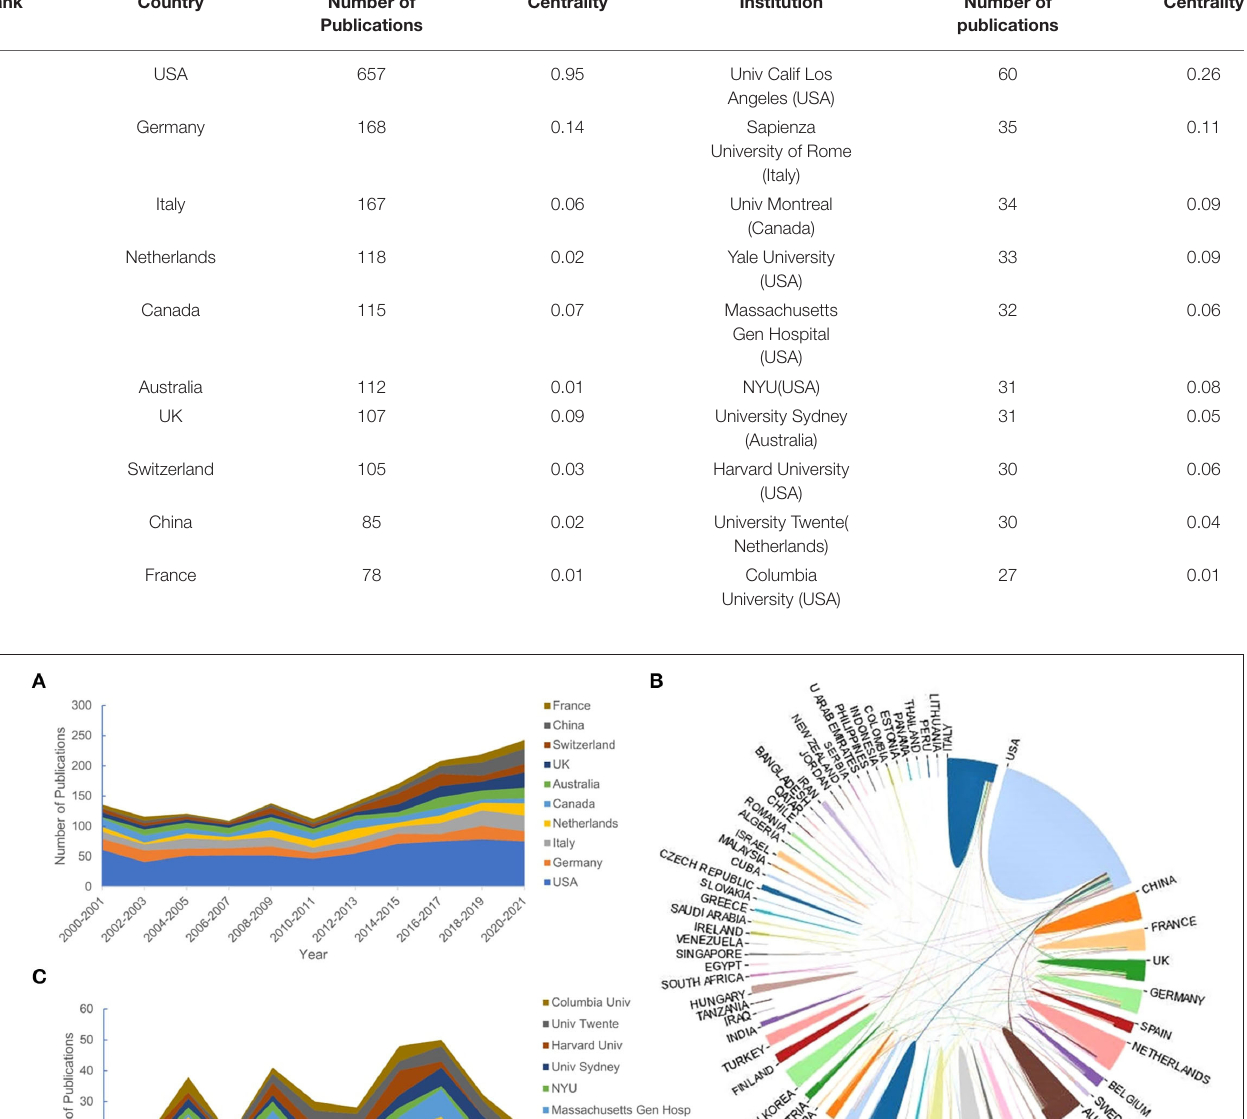
TABLE 1 | Top 10 countries and institutions with the highest number of publications from 2000 to 2021.